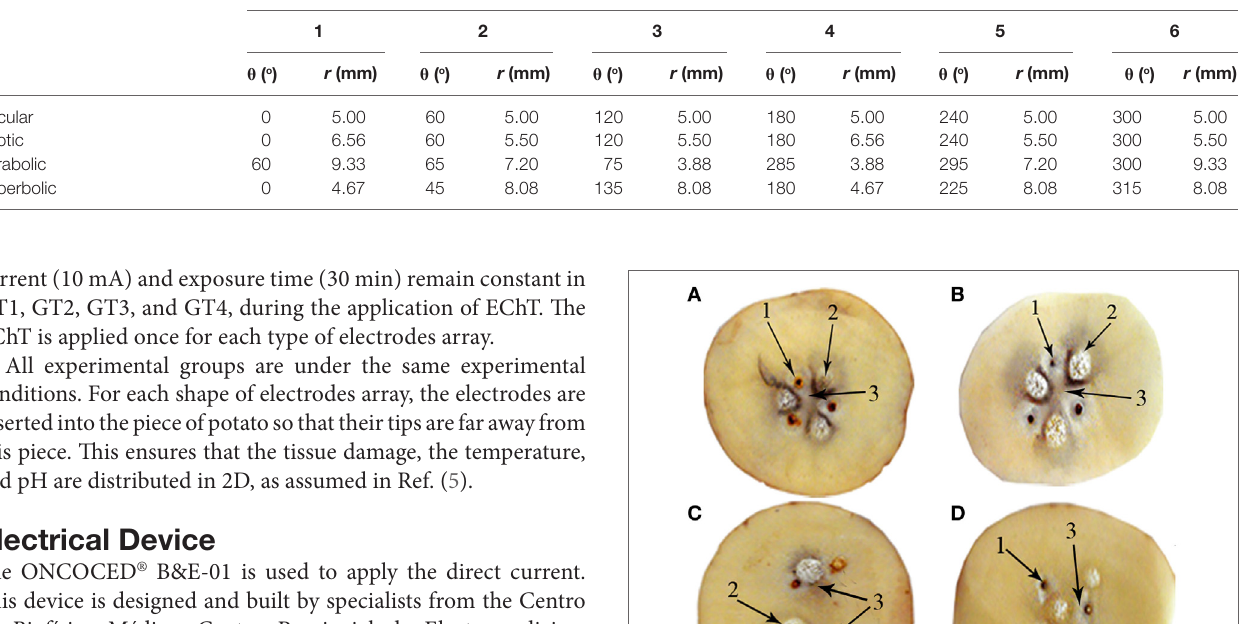
TaBle 2 | Polar coordinates ( r , θ ) of the six electrodes for each electrode array shape. shapes of electrode arrays number and positioning of each electrode